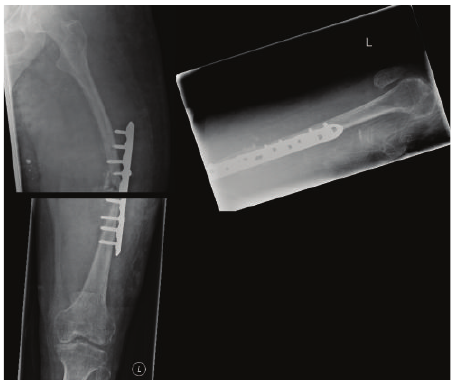
Figure 5: AP and lateral radiograph of the left femur immediately one month after open reduction, internal fixation.